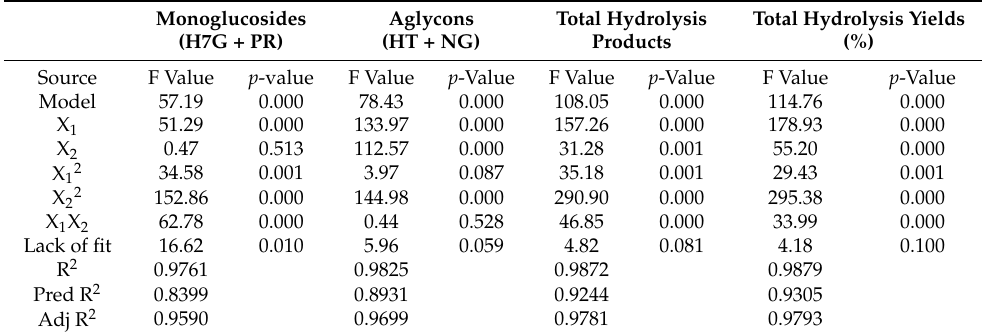
Table 2. Analysis of variance results for the regression